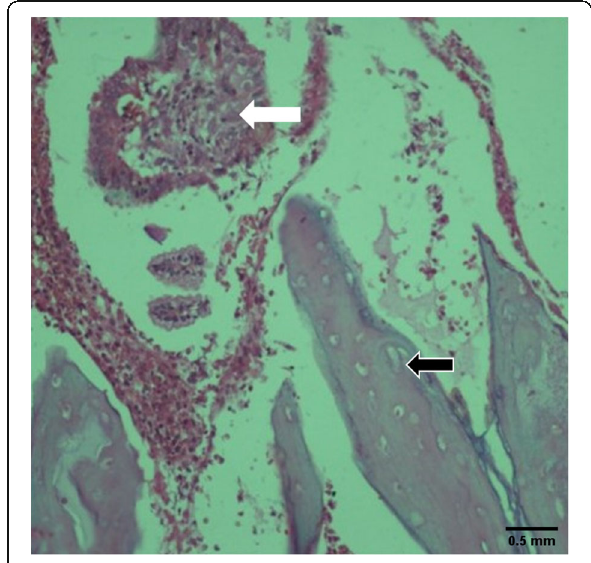
Fig. 8 High power (40×) view photomicrograph showing single endometrial gland (white block arrow) and stroma infiltrated by bony trabeculae (black block